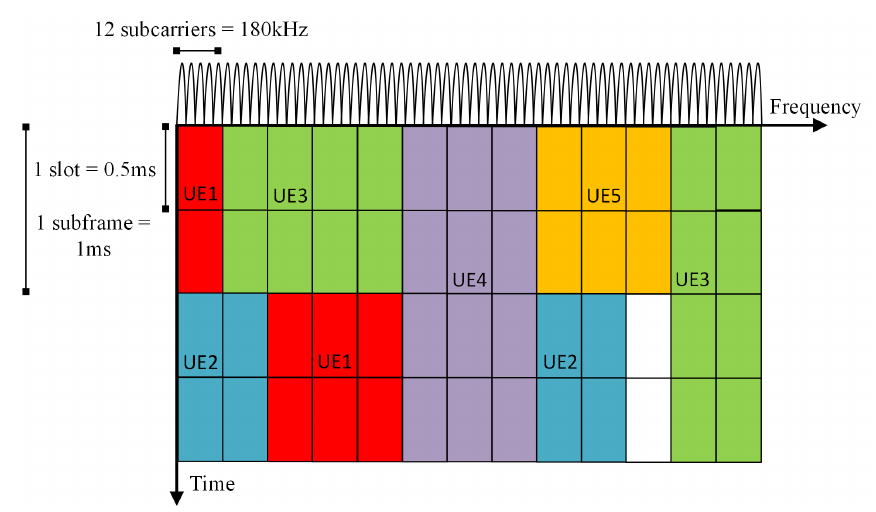
Figure 3. LTE time-frequency structure and user traffic scheduling. Each color represents a different UE that is scheduled by the Base